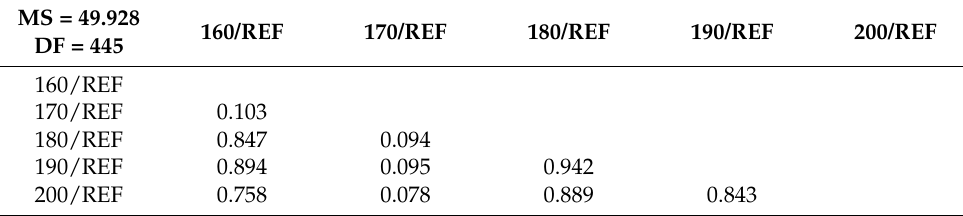
Table A4. Duncan ´ s multiple range test for changes in thermal diffusivity.